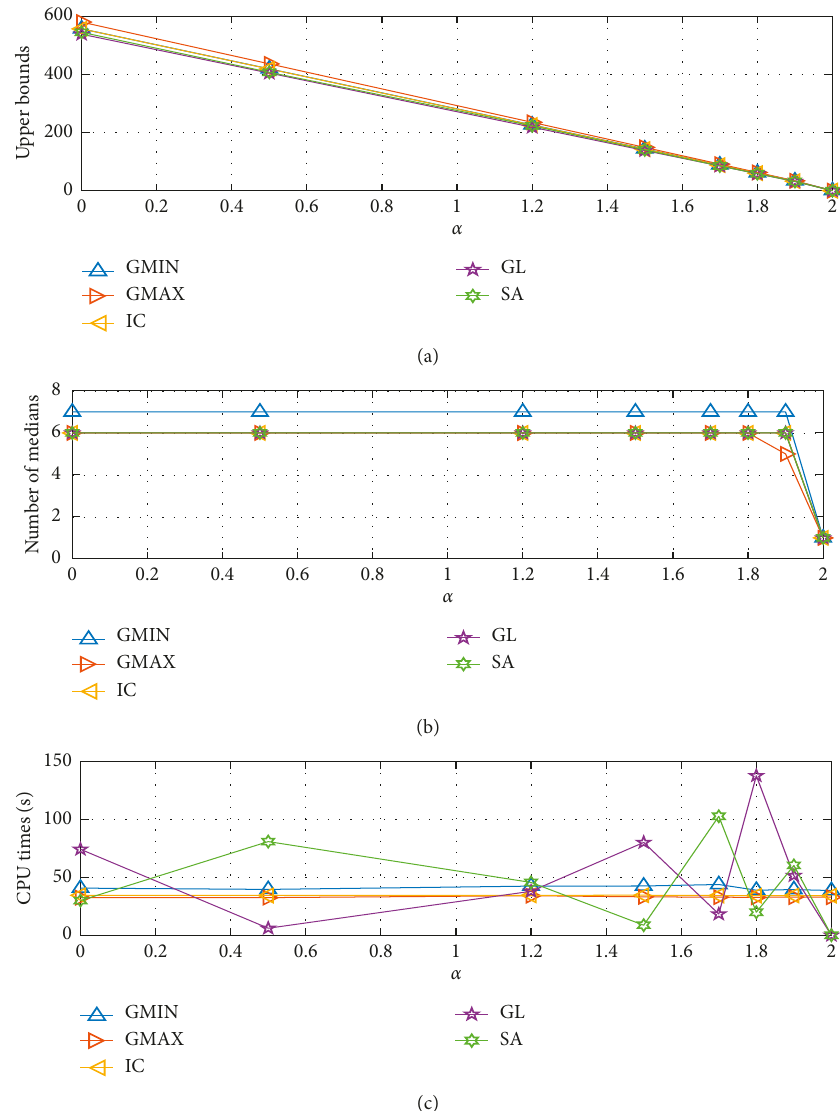
Figure 7: (a) Upper bounds, (b) number of facilities, and (c) CPU times in seconds for the instance #10 in Table 9 while varying α ∈ [ 0 ; 2 ] and using a radial coverage value of